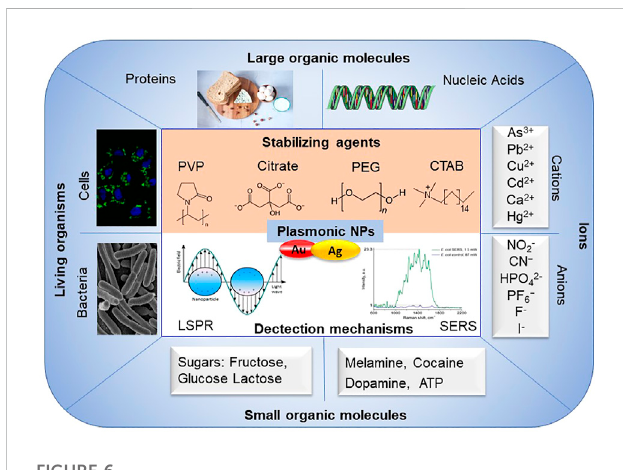
FIGURE 6 A schematic overview of mechanisms for plasmonic NPs-based biosensors for detection and their